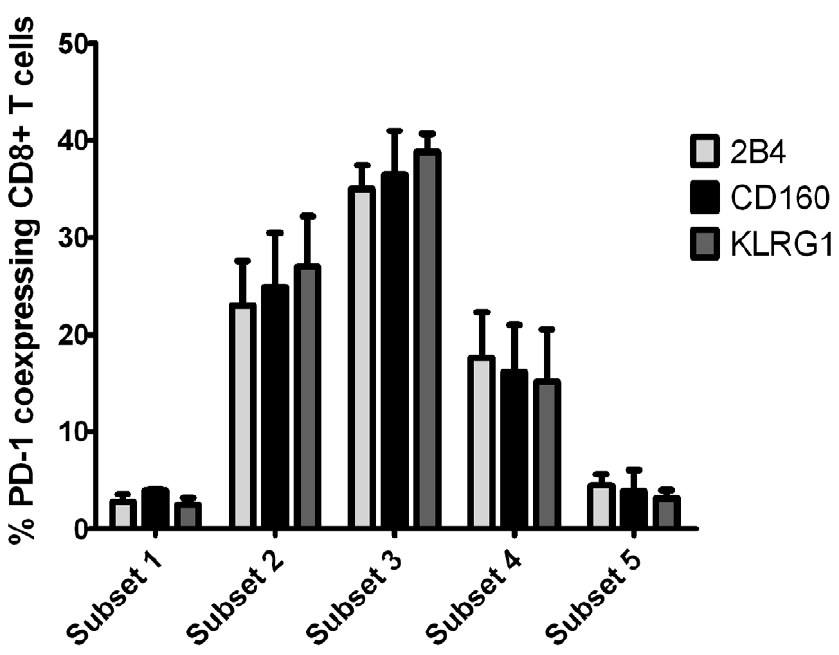
Figure 6. Coexpression of 2B4, CD160 and KLRG1 with PD-1 is linked to an intermediate differentiation stage. Frequency of CD8 + T cells coexpressing inhibitory receptors 2B4, CD160 and KLRG1 next to PD-1 is shown depending on the differentiation stage as defined in Fig. 5A. Values were calculated by dividing the number of coexpressing CD8 + T cells belonging to the 5 differentiation subsets analyzed by the total number of coexpressing CD8 + T cells. A total of 5 patients were analyzed.